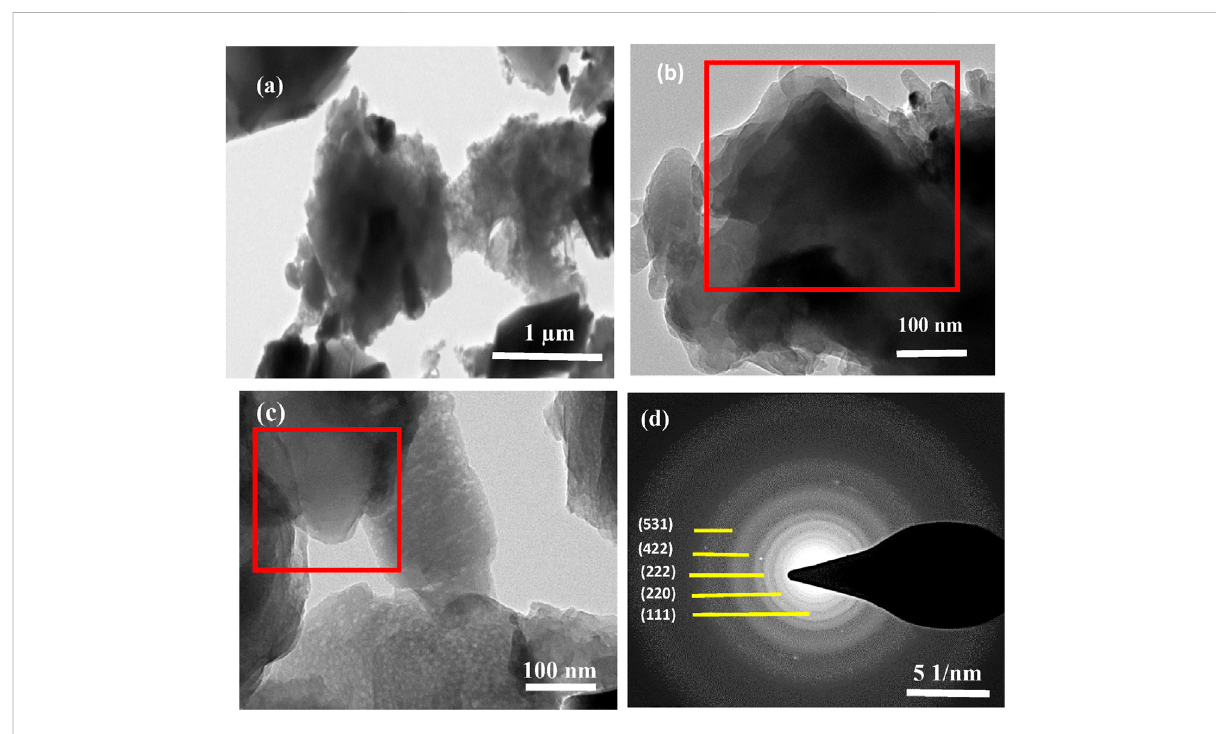
FIGURE 4 (A – C) TEM images of NiCo 2 S 4 with different magni fi cations (D) SAED pattern of NiCo 2 S 4